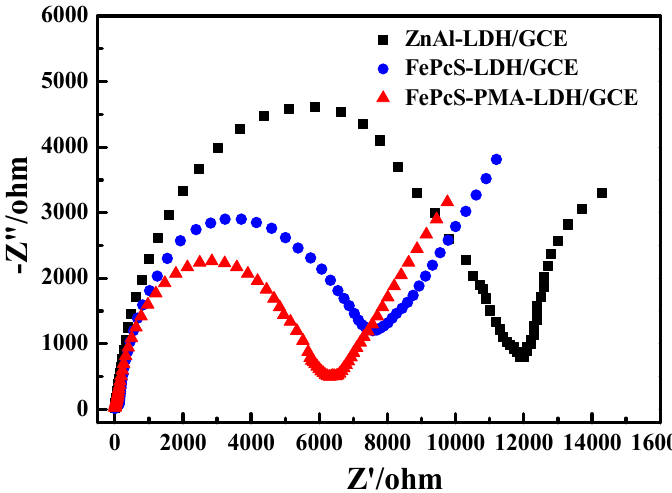
Figure 13. Nyquist diagrams obtained at ZnAl–LDH / GCE, FePcS–LDH / GCE, and FePcS–PMA–LDH / GCE in 0.1 M KCl solution containing K 3 [Fe(CN) 6 ] / K 4 [Fe(CN) 6 ] (both 5 mM).